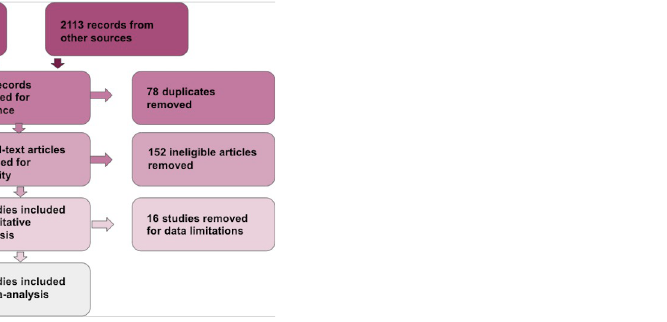
Fig 1. PRISMA diagram. PRISMA diagram showing the selection process for references included in the meta-analysis of the effects of GCs on telomere length.